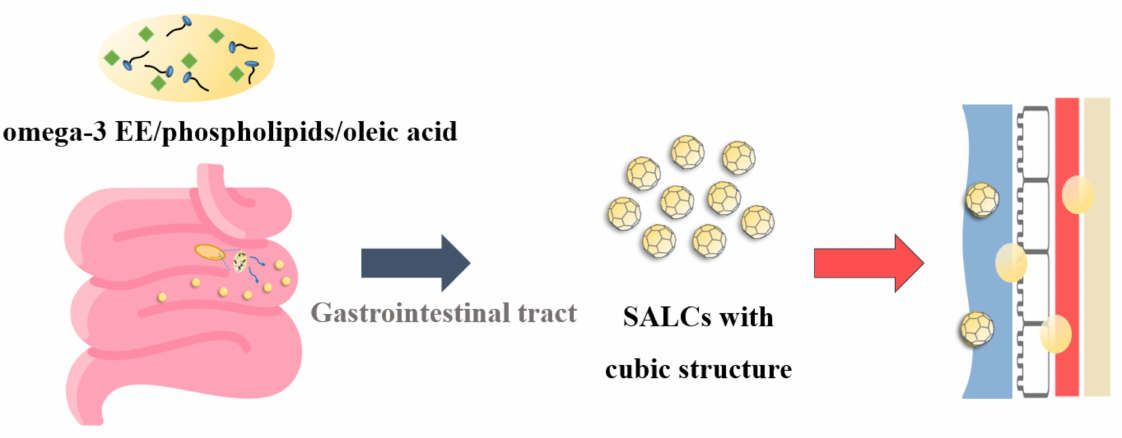
Figure 7. Schematic showing the mechanism of action that promotes omega absorption in SALC formulations. Abbreviations: EPA, eicosapentaenoic acid; DHA, docosahexaenoic